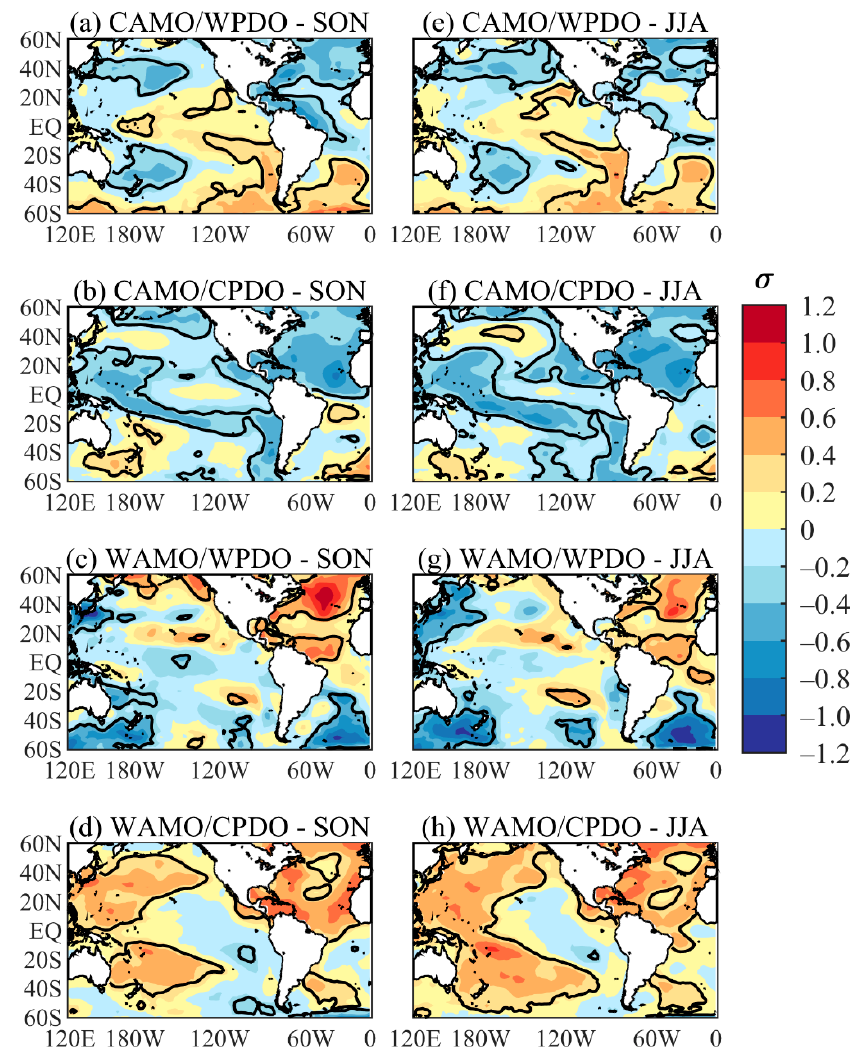
Figure 3. September–November SST mean standardized anomaly pattern in the: ( a ) CAMO/WPDO; ( b ) CAMO/CPDO; ( c ) WAMO/WPDO; and ( d ) WAMO/CPDO mean states. June–August SST mean standardized anomaly pattern in the: ( e ) CAMO/WPDO; ( f ) CAMO/CPDO; ( g ) WAMO/WPDO; and ( h ) WAMO/CPDO mean states. Shades interval is every 0.2 SDs. The continuous line encompasses significant SST anomalies at a 95% confidence level based on the Student’s t